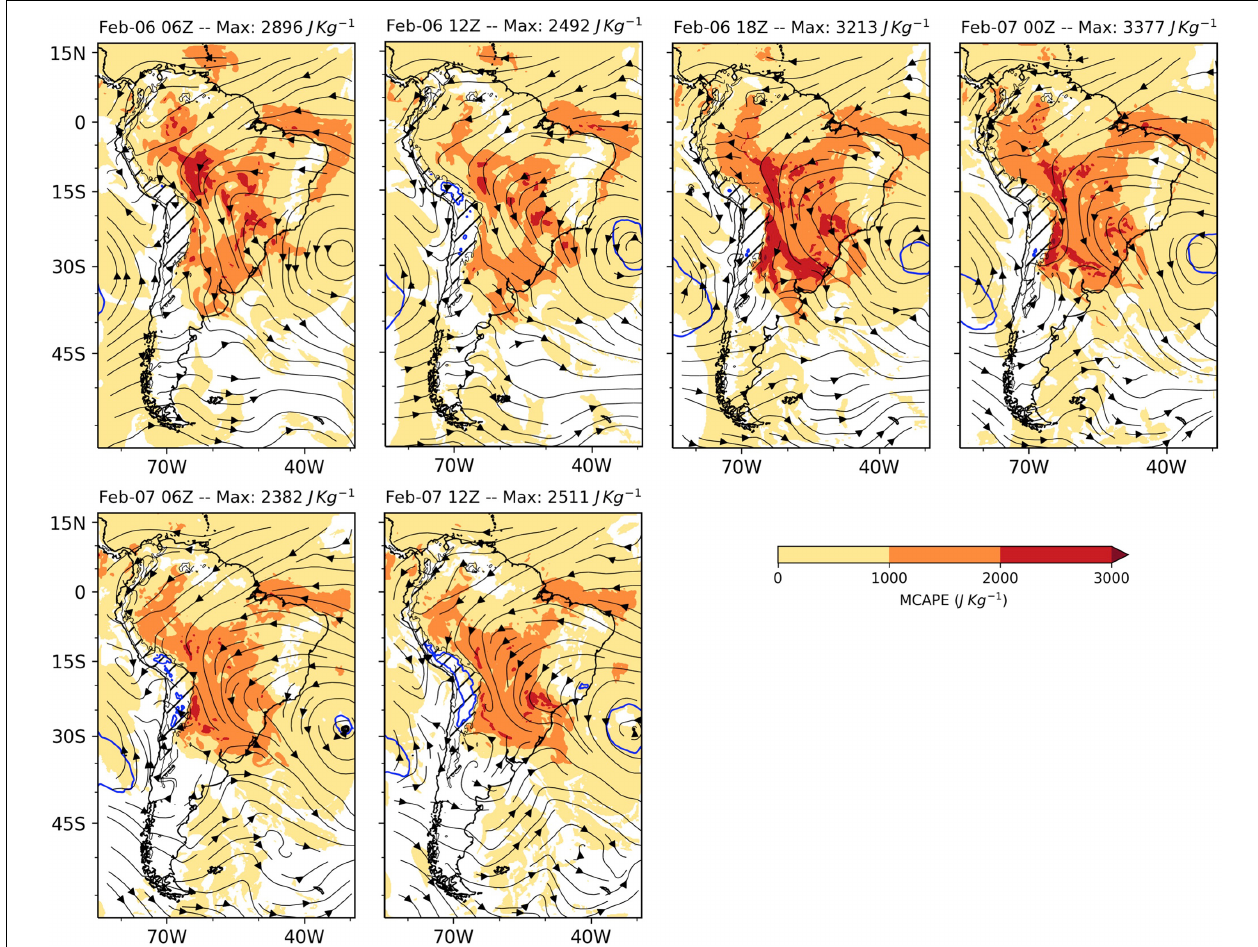
FIGURE 3 | WRF simulation (D01, 18 km) of the SLLJ case during February 06 00Z to 07 12 Z, 2003. The maps show the evolution of the MCAPE in the lower 3,000 m during the simulation. The streamlines show the 850 hPa horizontal wind and the blue contour delineate the 1,020 hPa sea level pressure.